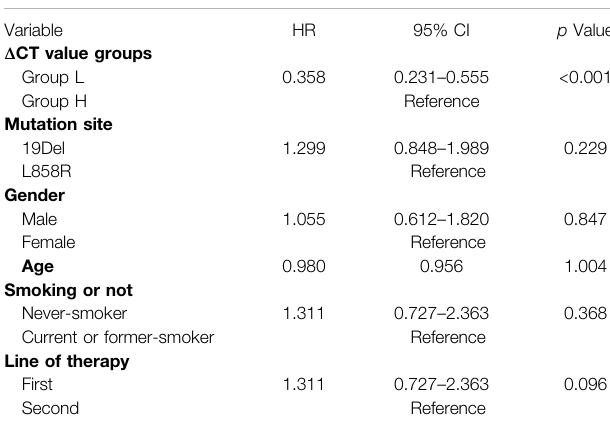
TABLE 2 | Multivariate analyses of PFS by Cox regression